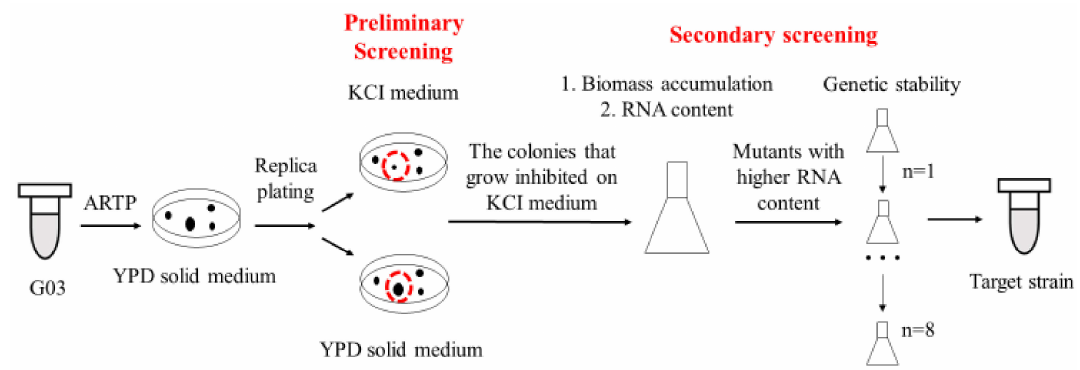
Figure 1. Technical route of high-ribonucleic acid mutants